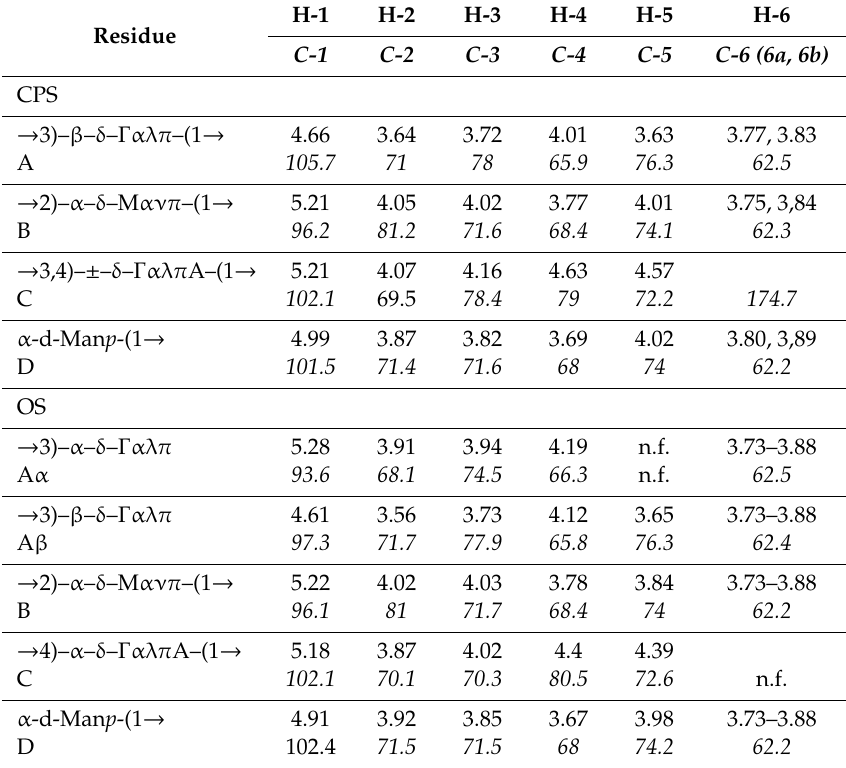
Table 3. 1 H and 13 C NMR chemical shifts ( δ , ppm) of the K57 CPS from K. pneumoniae KPi8289 and oligosaccharide 1 (OS) derived by cleavage of the CPS with depolymerase